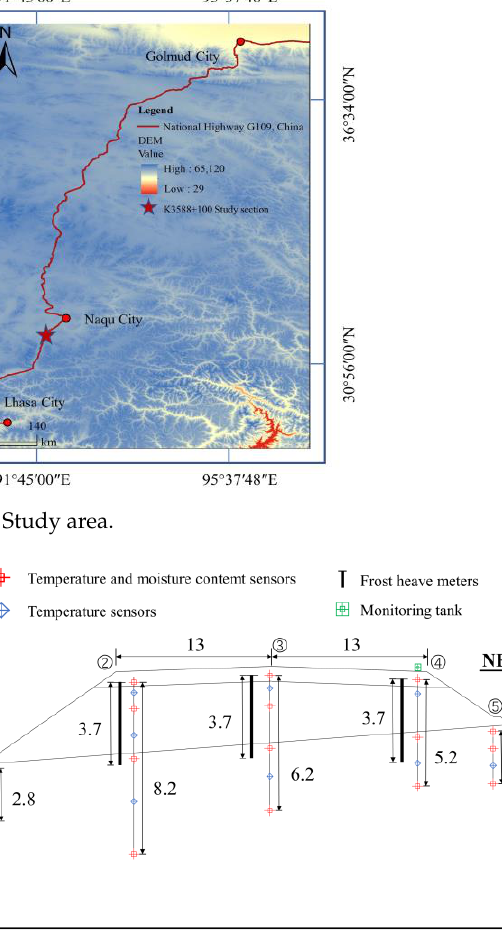
Figure 1. Study area.